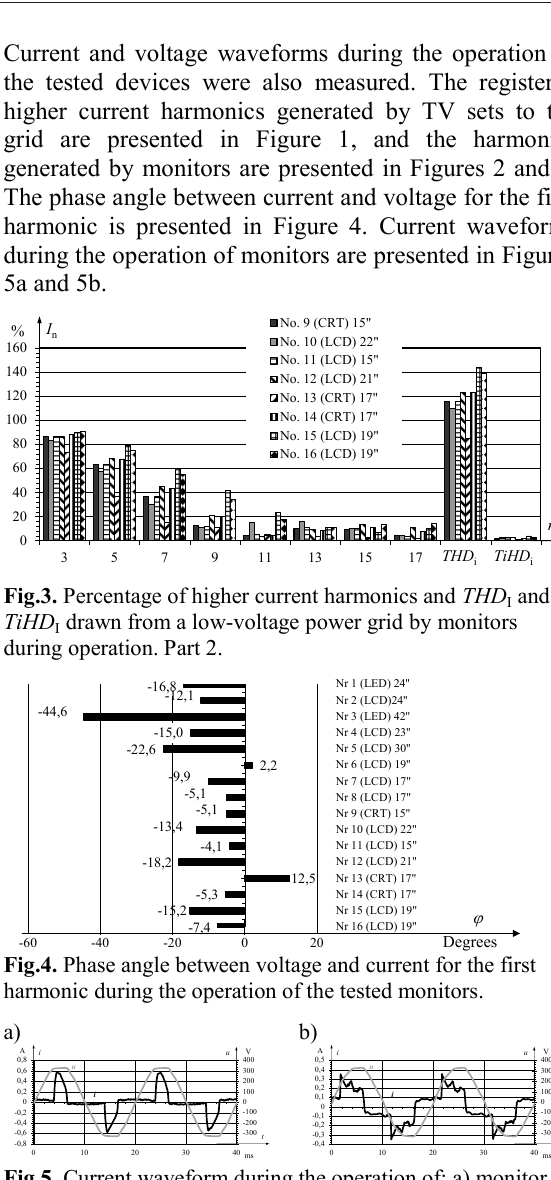
Fig.5. Current waveform during the operation of: a) monitor No. 10 (LCD “22), b) monitor No. 3 (LCD